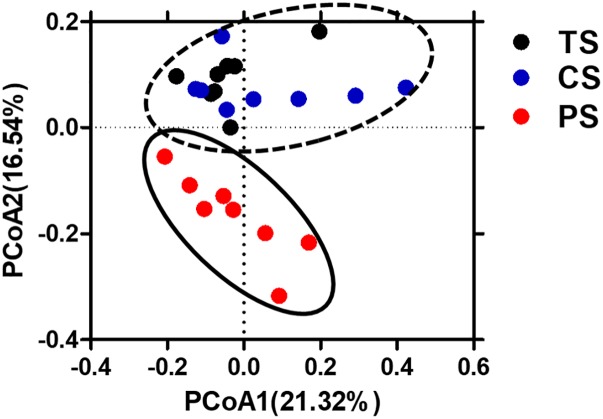
Principal coordinates analysis (PCoA) of bacterial communities in the colonic digesta of pigs (based on the Bray–Curtis distance). Circles with dash line or solid indicate that groups were significantly distinct using AMOVA analysis (P < 0.05). TS, tapioca starch; CS, corn starch; PS, pea starch.